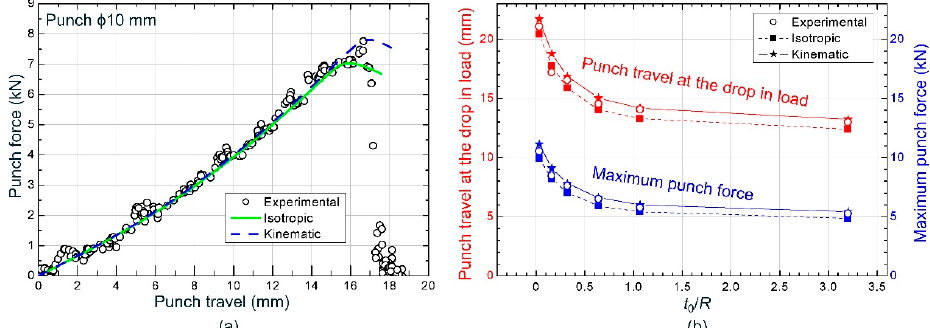
Figure 10. ( a ) Experimental punch force vs. punch travel for φ 10 mm cylindrical punch; ( b ) maximum force and punch travel at the drop in load vs. t 0 /R for hemispherical ( φ 100 mm) and cylindrical punches (ranging from φ 20 up to φ 1 mm).